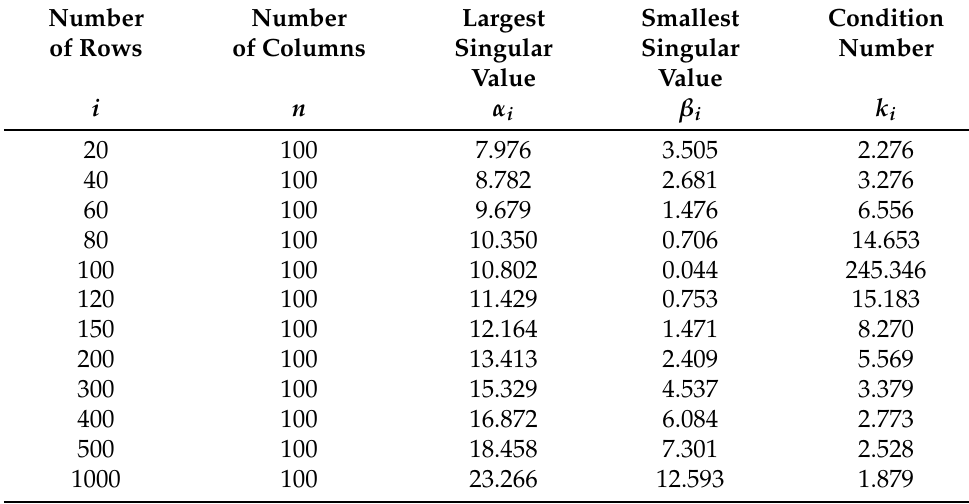
Table 5. The anomaly in random